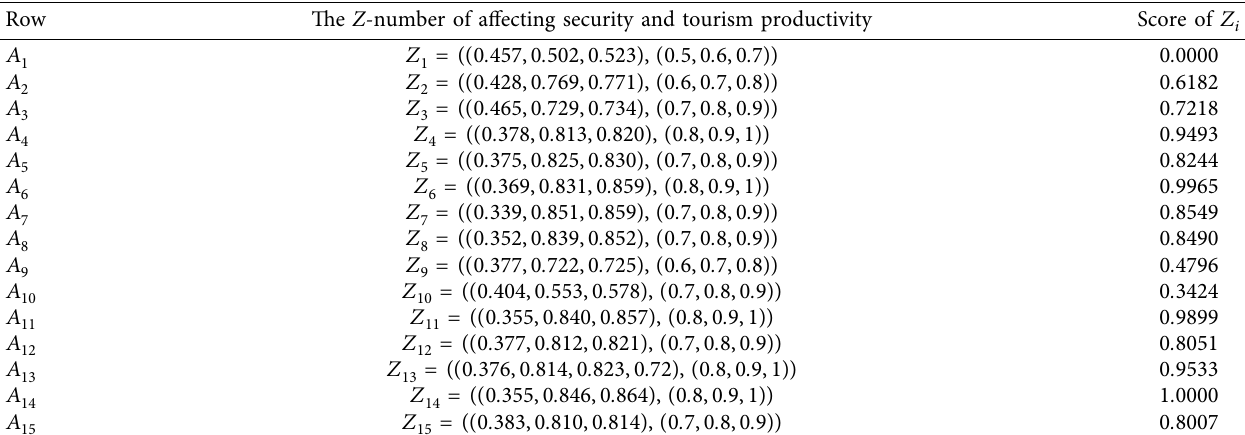
Figure 4: Te chart of factors afecting security and tourism productivity. Table 6: Ranking of the factors afecting security and tourism